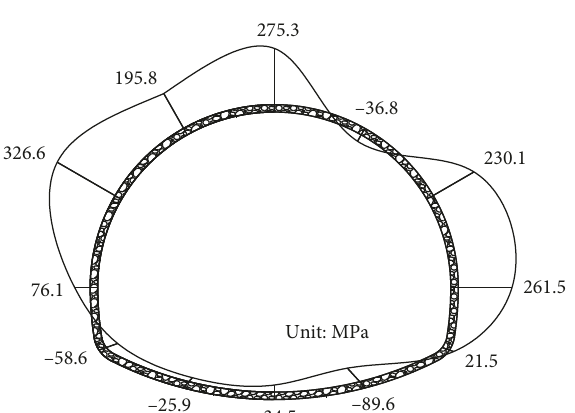
Figure 16: Final stress distribution of the steel arch